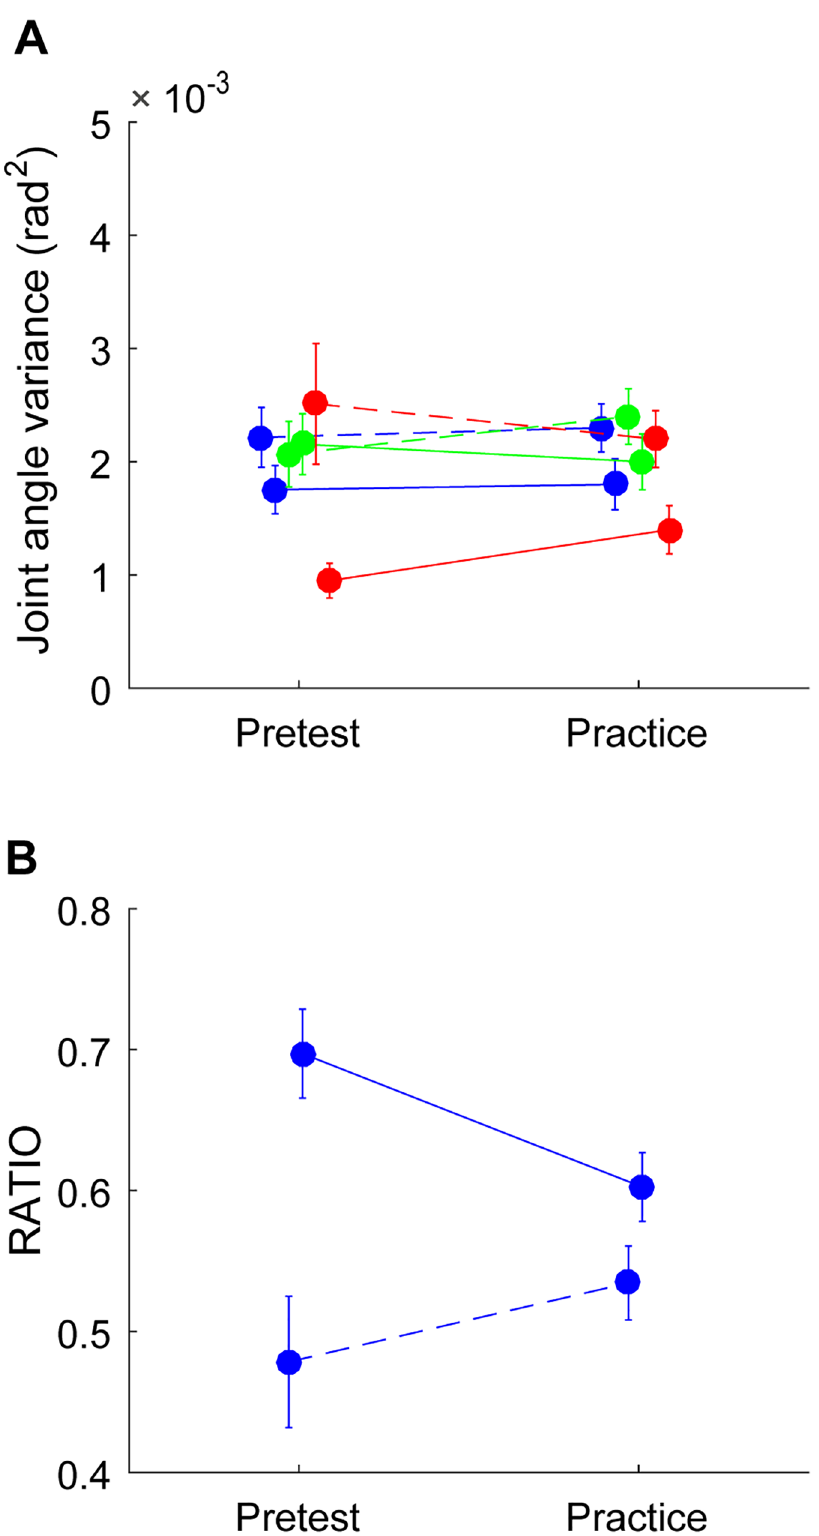
Fig 3. Joint angle variance,GEV, NGEV and flexibility for each Instant in the pretest and during practice per obstacle. Panel A depicts joint angle variancein blue, GEV in green and NGEV in red and